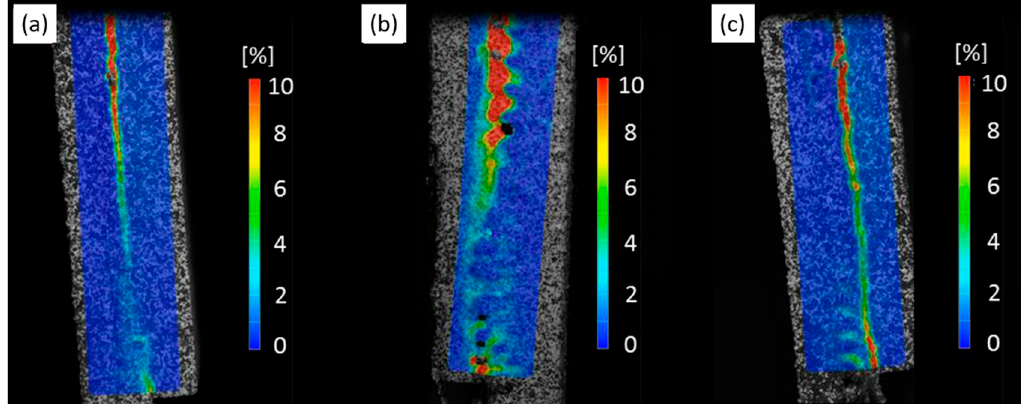
Figure 8. Optical strain measurement during tensile shear testing of thermally direct joined carbon fiber-reinforced polyether-ether-ketone (CF-PEEK) with additive manufactured titanium with ( a ) as-built surface, ( b ) groove-shaped surface structures, and ( c ) pin-shaped surface structures .